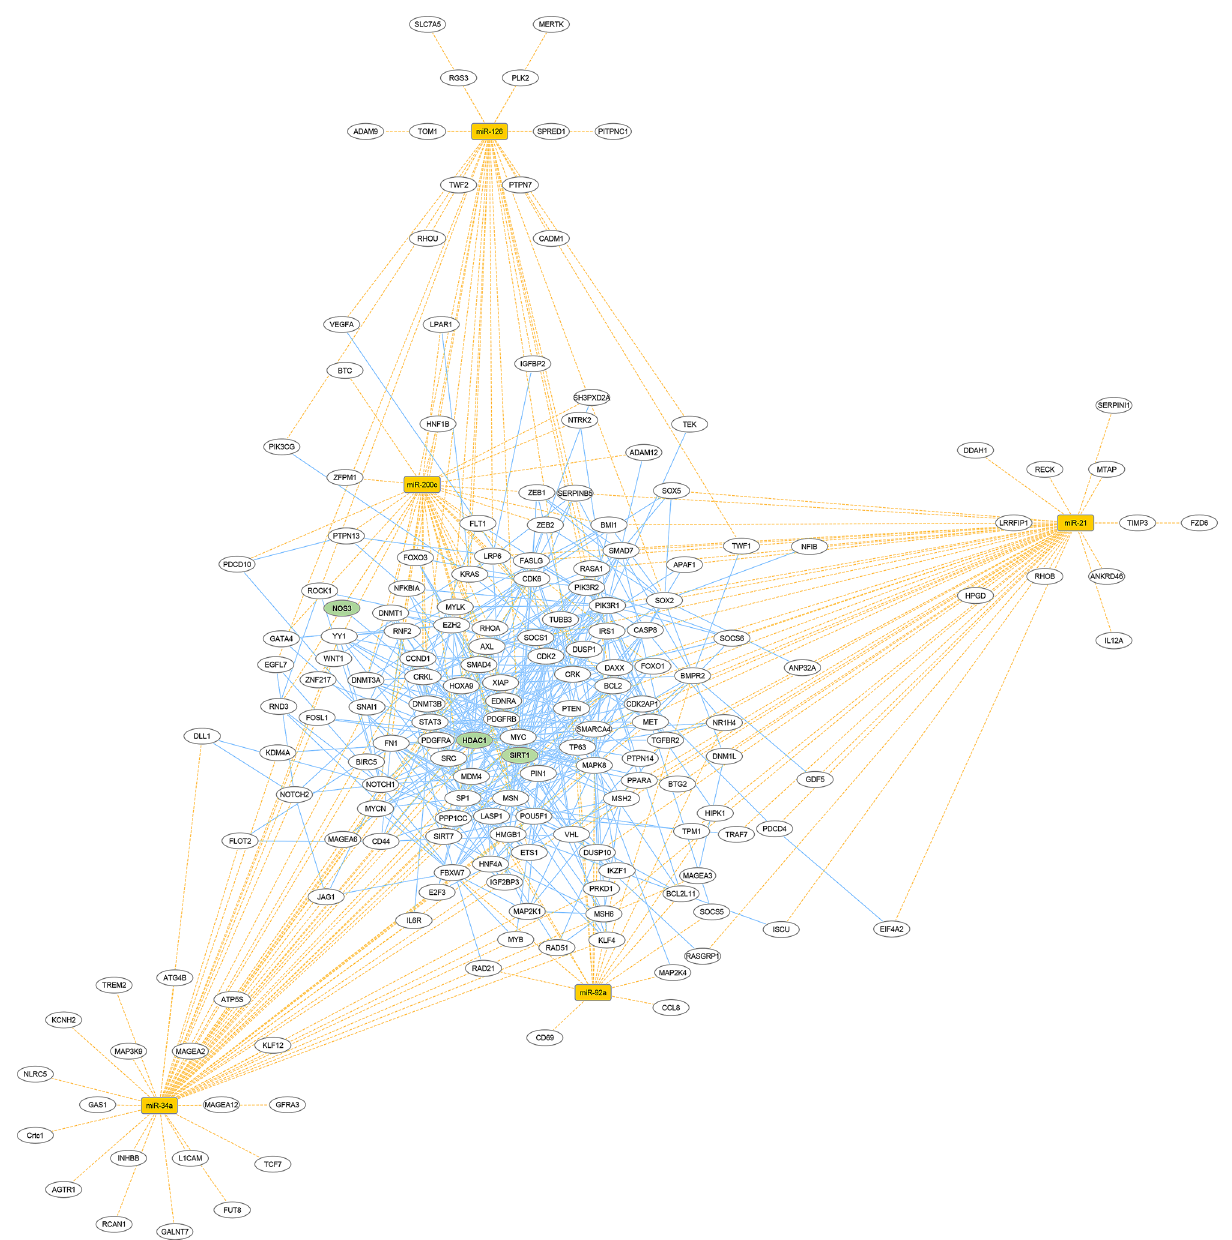
Figure 7. Visualization of miR-target interaction network. miR-21-5p, miR-34a-5p, miR-92a-3p, miR-126-3p, and miR-200c-3p are displayed in yellow squares, while white ovals represent their targets. Dotted yellow lines and solid blue light ones indicate miR-mRNA and protein–protein interaction, respectively. The graphical representation was generated with Cytoscape software version 3.7.2 using the Organic layout (https:// cytos cape.